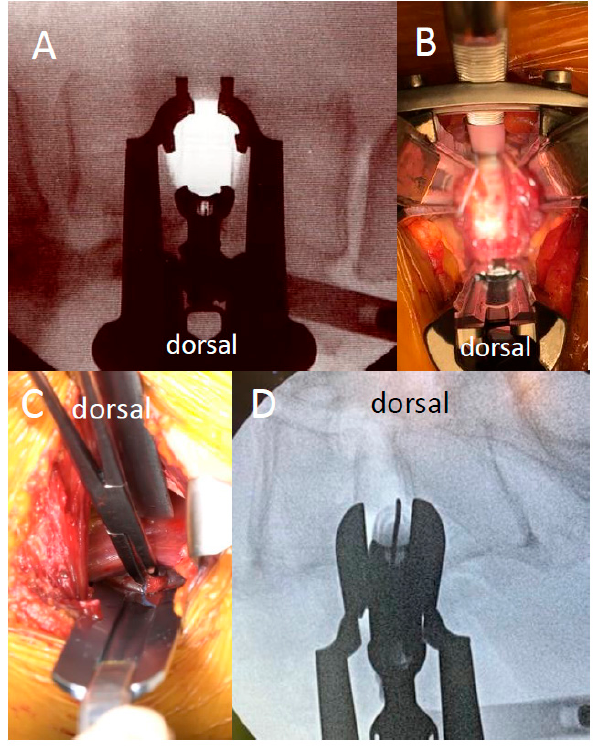
Figure 3. ( A ) In group X, after exposing the lateral portion of the psoas major muscle, we split and entered it with fluoroscopic view of the intervertebral disc’s location. ( B ) In group X, the split psoas muscle was pulled forward after driving a shim into the intervertebral disc. ( C ) In group A, the anterior third of the psoas muscle was gently split, and the intervertebral disc was exposed. ( D ) In group A, the anterior third of the intervertebral disc was reached under fl uoroscopy, and the psoas muscle was dilated with a retractor.